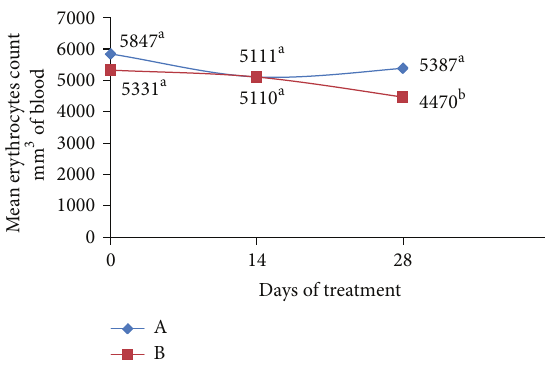
Figure 3: Mean values of erythrocytes count ( ×10 3 ) in the periph- eral blood of animals treated with probiotics (A) and nontreated animals (B). a , b different letters represent significant differences in statisticalterms( 𝑃 < 0.05 ).Referencevalues:6000–8000 × 10 3 /mm 3 of blood. Figure 4: Mean rates of hemoglobin in the peripheral blood